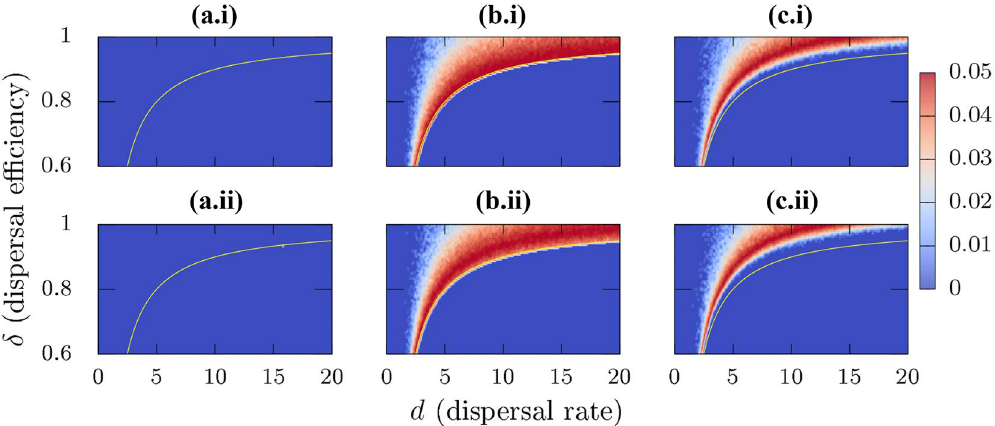
Figure 7. (i) SE ( P per ) projection on the ( d , δ) plane for homogeneous patches, and (ii) for the heterogeneous patch case. [( a.i ),( a.ii )] correspond to all-to-all connected system, [( b.i ),( b.ii )] to fixed NBM, and [( c.i ),( c.ii )] to NBM rewiring every 100 time units. The blue shaded area corresponds to regimes where the error is zero. Positive values are highlighted by colors as per the attached color bar. The boundary between persistence and extinction for the all-to-all connected system is again indicated by a yellow curve for comparison in all the 100 for these calculations. The dynamical differences between all-to-all connected, and panels. N ensemble = NBMs are even more obvious in these